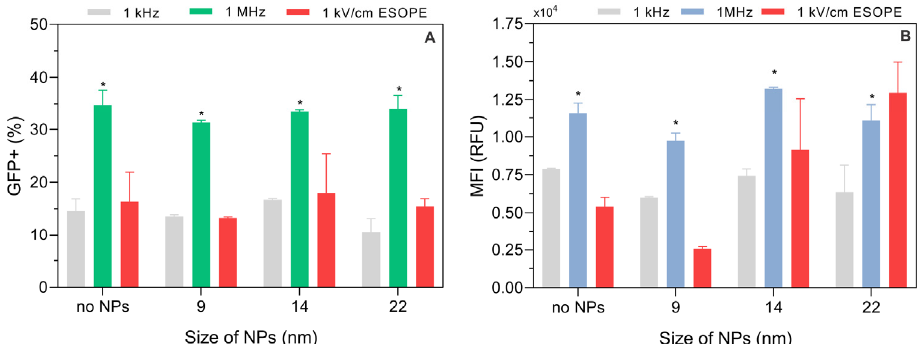
Figure 11. Dependence of electrotranfection efficiency on PEF parameters and AuNP size, where ( A ) percentage of GFP positive cells; ( B ) median fluorescence intensity. Asterisk (*) corresponds to statistically significant difference ( p < 0.05).